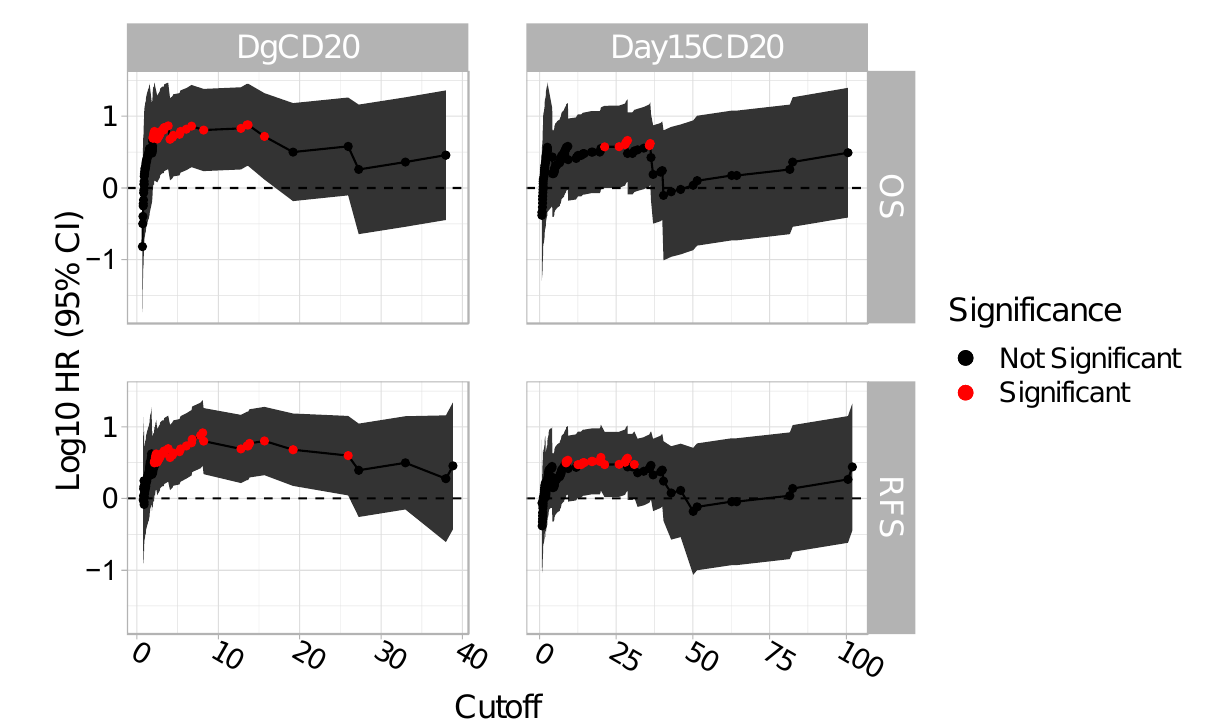
Figure 3. “Sliding window” approach on determining the succession of cut-off points that are significantly associated with RFS and OS. Each possible cut-off point was assessed and their respective log10 HR (95% CI) were plotted. Table 2. Variables associated with RFS and